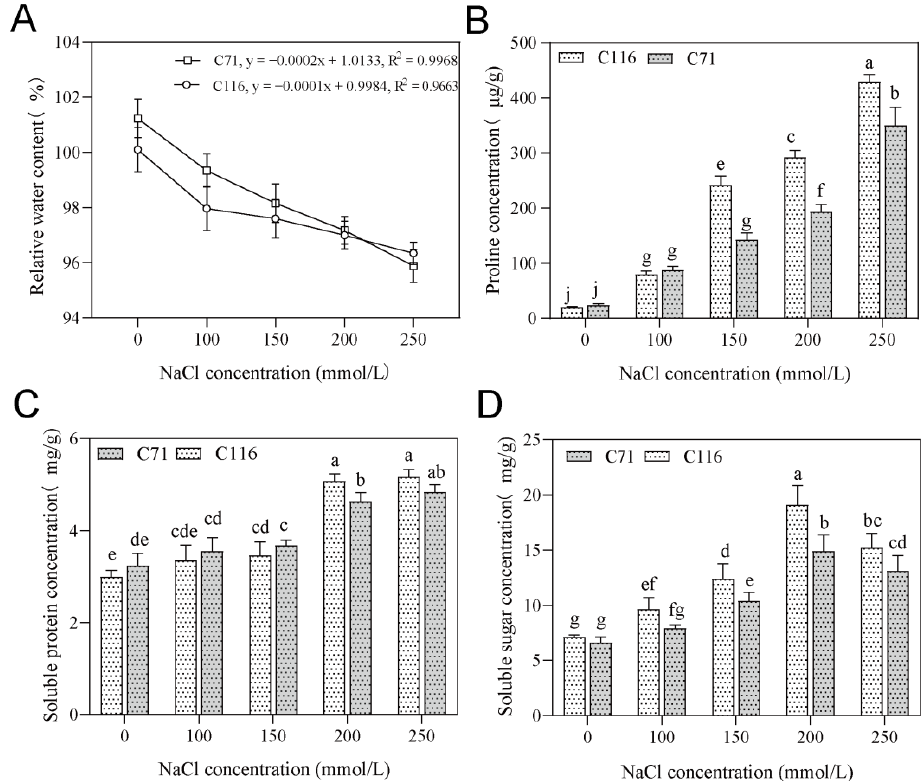
Figure 2. Accounting for variations in osmoregulatory substances under different salt concentrations. ( A ) The trend lines for RWC in both materials under salt stress: linear regression, coefficient of determination ( R 2 ); y and x are the vertical and horizontal values, respectively. Accumulation of proline ( B ), soluble protein ( C ), and soluble sugar ( D ) in two materials under different salt concentrations. The line bars represent the standard deviation of the means. Different letters denote significant differences at the p < 0.05 level found by MRT.